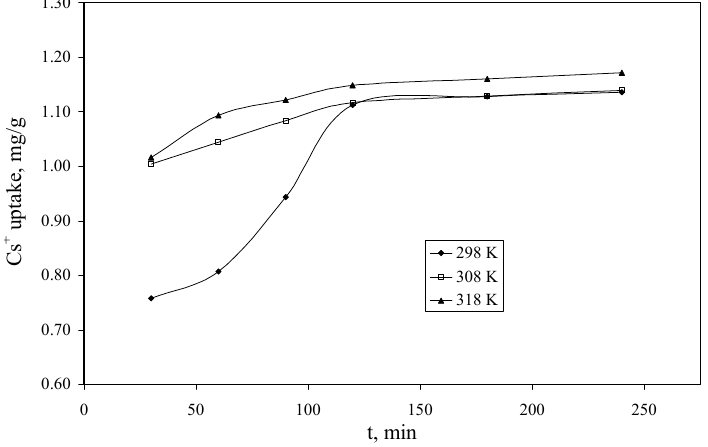
Figure 6. The dependence of the Cs + uptake versus the contact time (C V = 25 mL, pH = 8, m = 0.1